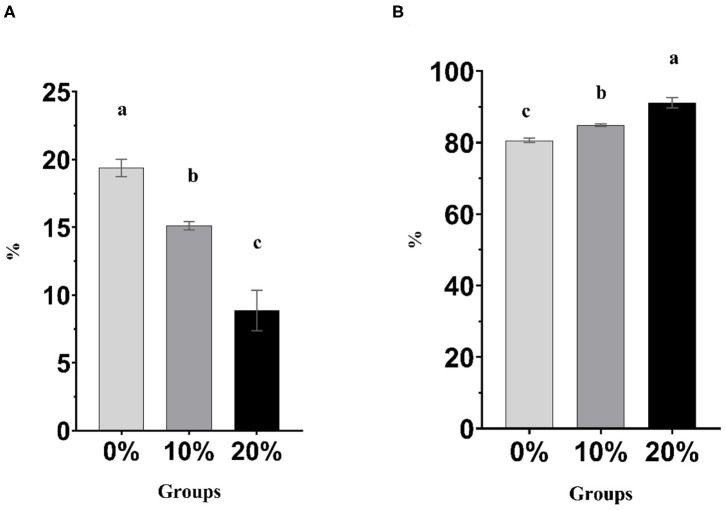
(A) Percentage of CH4 in the produced gas. (B) Percentage of CO2 in the produced gas. Bars with different superscripts are different (P < 0.05).